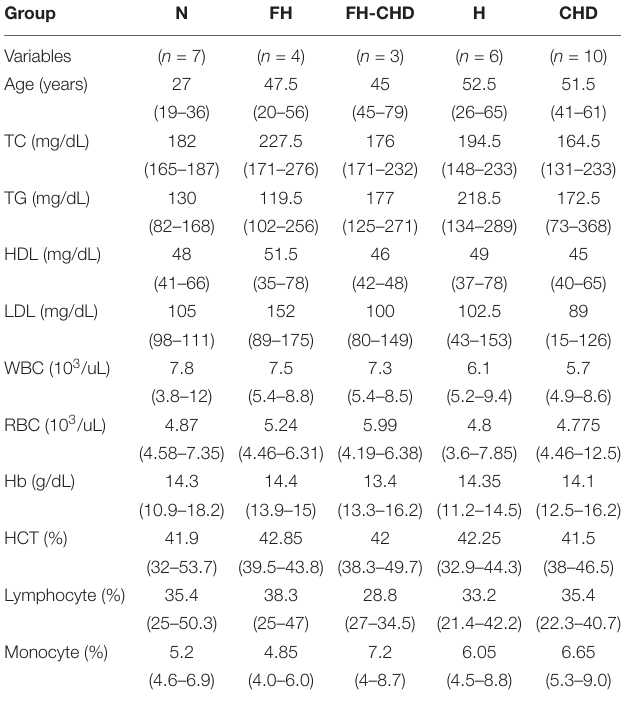
TABLE 3 | Characteristics of the